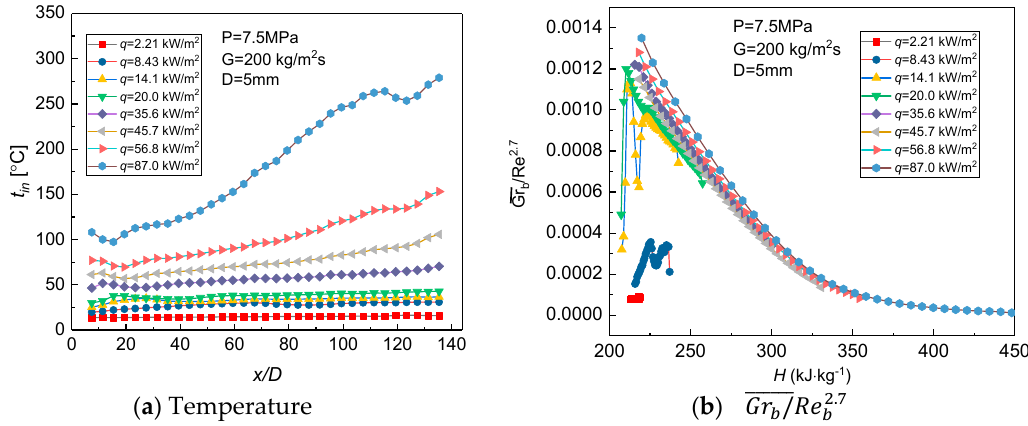
Figure 6. Variation of inner-wall temperatures and mixed convection ( Gr b / Re 2.7 ) at different heat fluxes for pressure of 7.5 MPa and mass flux of 200 kg/m 2 s. ( a ) Relationship between temperature and tube length (x/D); ( b ) Relationship between Gr b / Re 2.7 and b